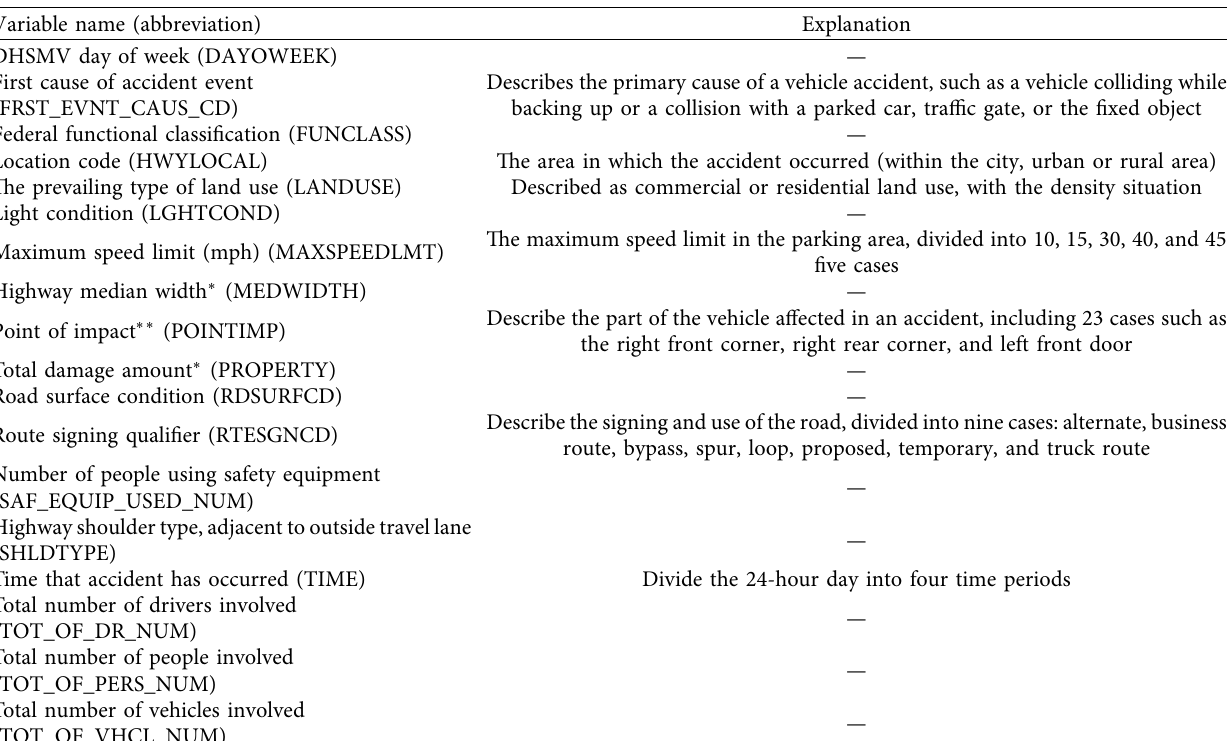
Table 9: Variable names and abbreviations in the